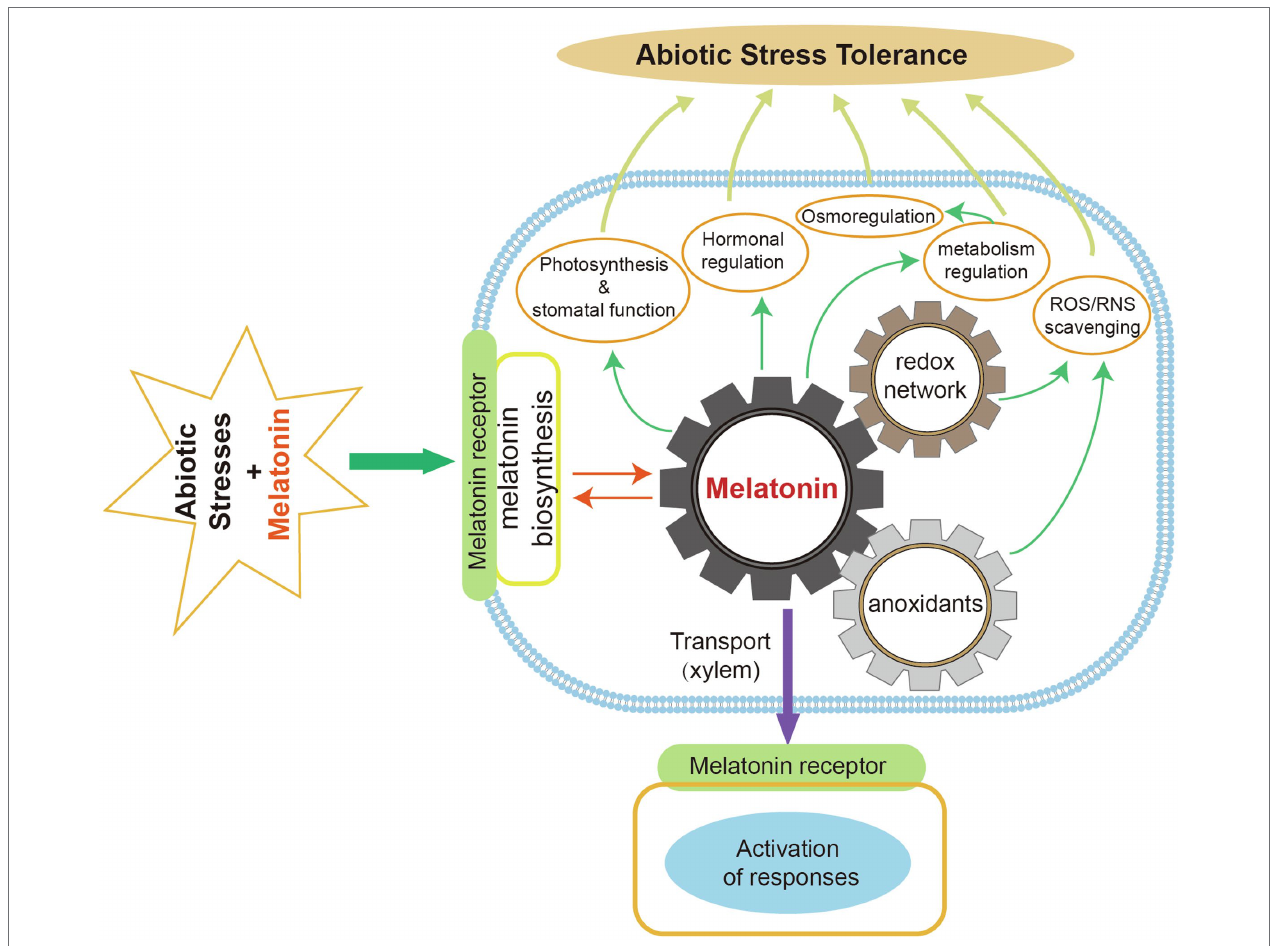
FIGURE 5 | Roles of melatonin in improving plant abiotic stress tolerance. Exogenous melatonin can remove ROS and RNS by interacting with melatonin receptors to induce endogenous melatonin production and increased antioxidant levels. Melatonin facilitates photosynthesis and stomatal functions. It also regulates plant hormones, osmosis, and metabolism in response to abiotic stresses. Melatonin can be transported to various plant organs via the xylem and then activate stress